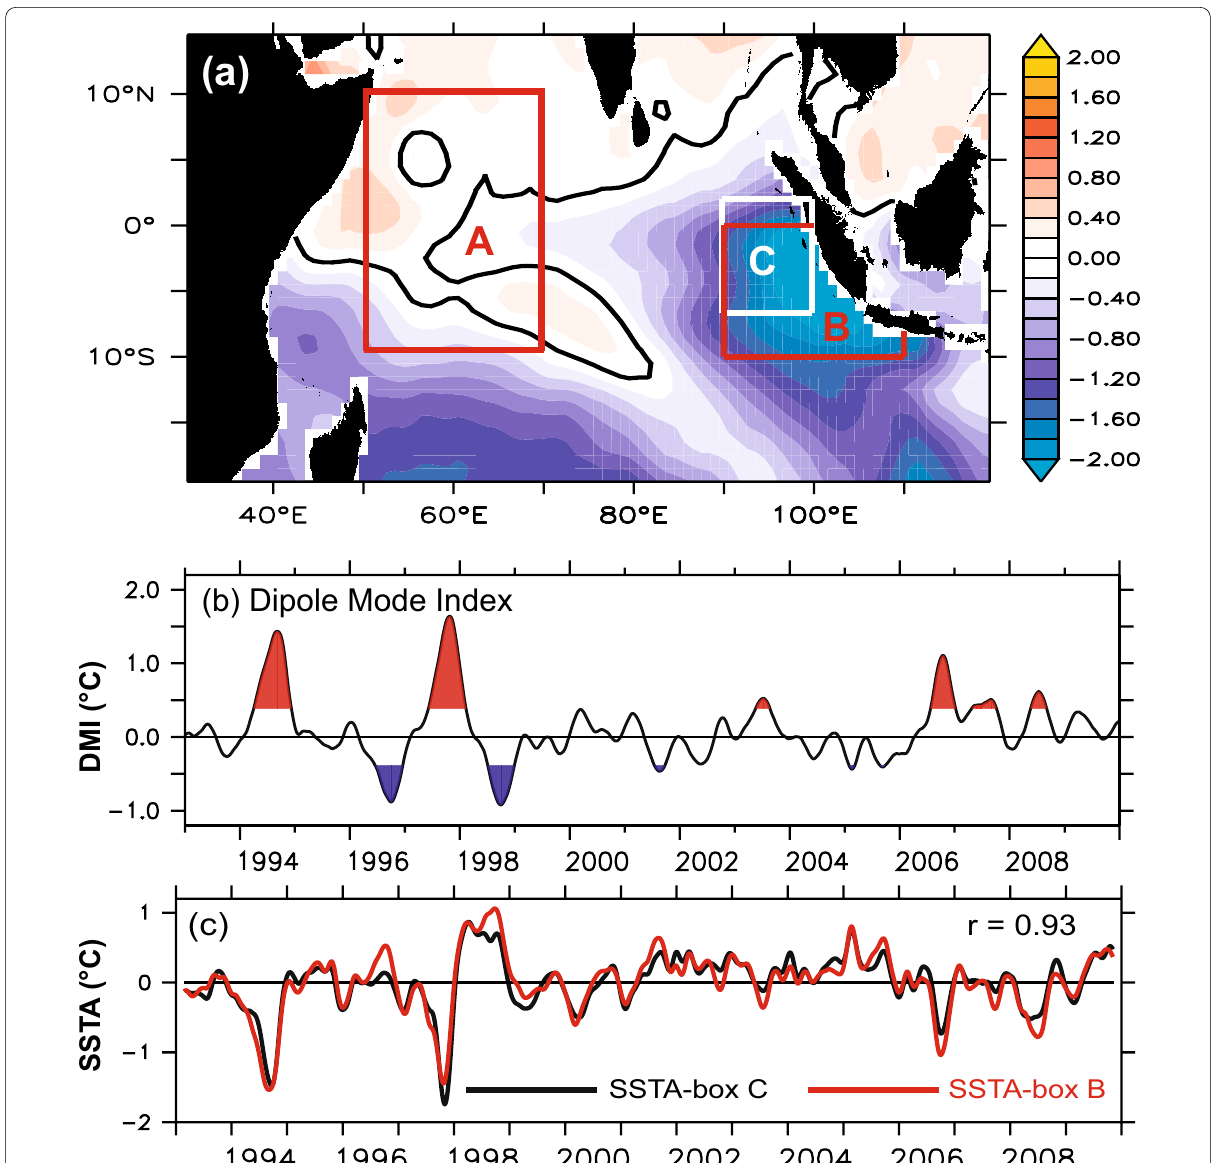
Fig. 1 a Area for the averaged SSTA calculation. Box-A is in the western region (10°S–10°N, 50°E–70°E) and box-B is the eastern region (10°S– Equator, 90°E–110°E). The Dipole Mode Index (DMI) is defined as the difference in averaged SSTA between western and eastern regions. Box-C (8°S–2°N, 90°E–100°E) is the area for the heat budget calculation. b Time series of DMI with positive (negative) IOD events highlighted in red (blue). c Time series of SSTA averaged over box-B (red) and that averaged over box-C